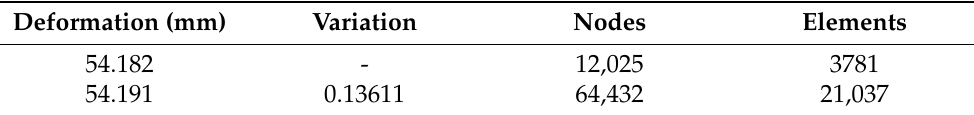
Figure 9. ( a ) Base structure of the viscoelastic damping layer. ( b ) Changing of extension and compression of the viscoelastic damping layer. ( c ) Final executive drawings of the D39 200 locomotive wheel. The mesh convergence was conducted by decreasing the element size for the viscoelas- tic damping layers of the web and under the rim. The viscoelastic damping layers on the web and under the rim were chosen to track the convergence since they consisted of both web and under the rim damping components. Table 5 shows the details of the convergence results of the viscoelastic damping layer. Table 5. Mesh convergence of damping layers on the web and under the rim.